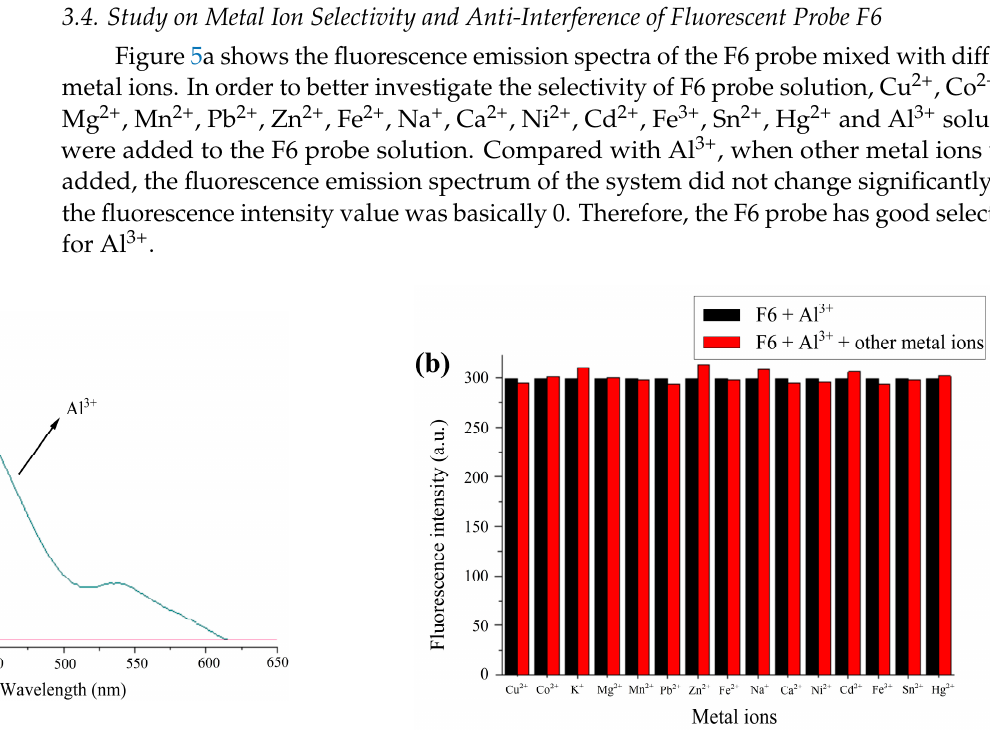
Figure 4. ( a ) Fluorescence spectra of F6 combined with Al 3+ at different concentrations; ( b ) standard curve for the detection of Al 3+ by fluorescence probe F6.